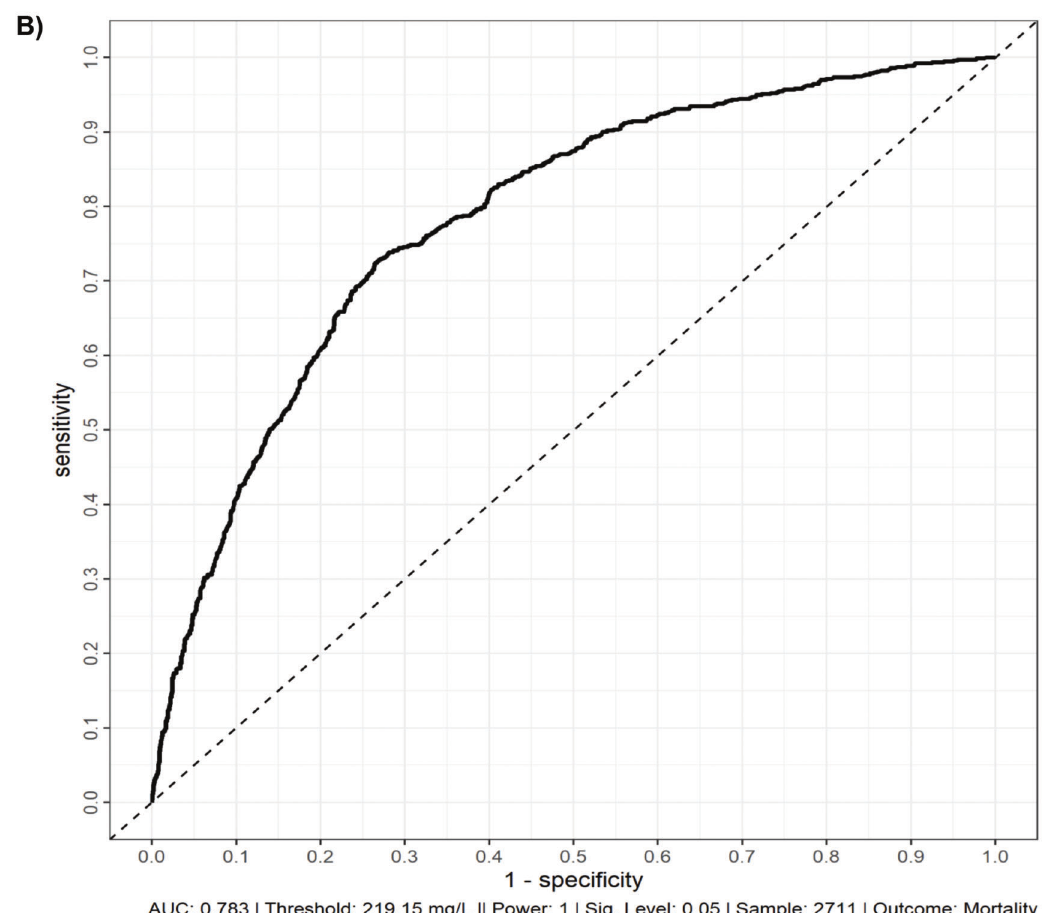
Figure 1 - ROC curves of D-Dimer (A) and C-reactive protein (B) with hospital mortality as the outcome. These ROC curves demonstrate the discrimination of D-dimer (A) and C-reactive protein (B) for hospital mortality. ROC, receiver operating characteristic curve; AUC, area under the curve; FEU, fibrinogen equivalent